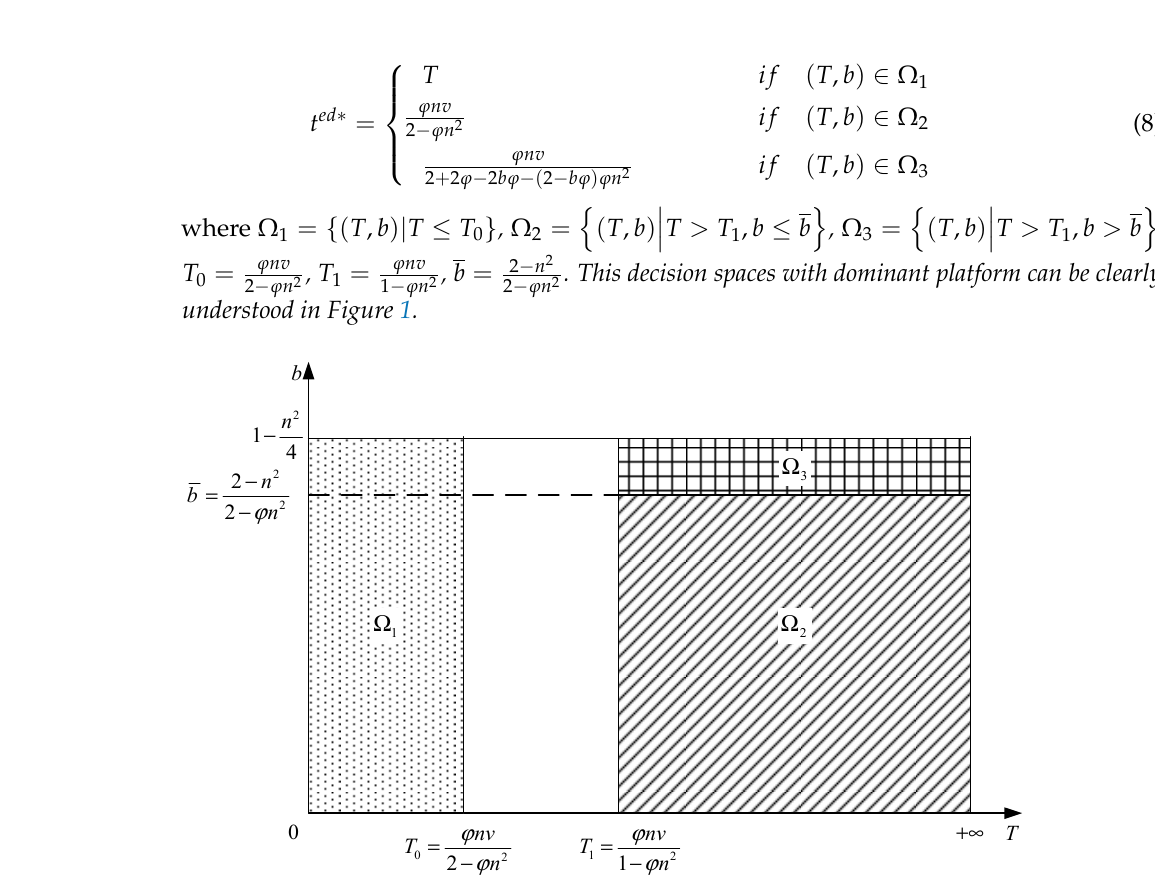
Figure 1. Division of decision space with a dominant platform.